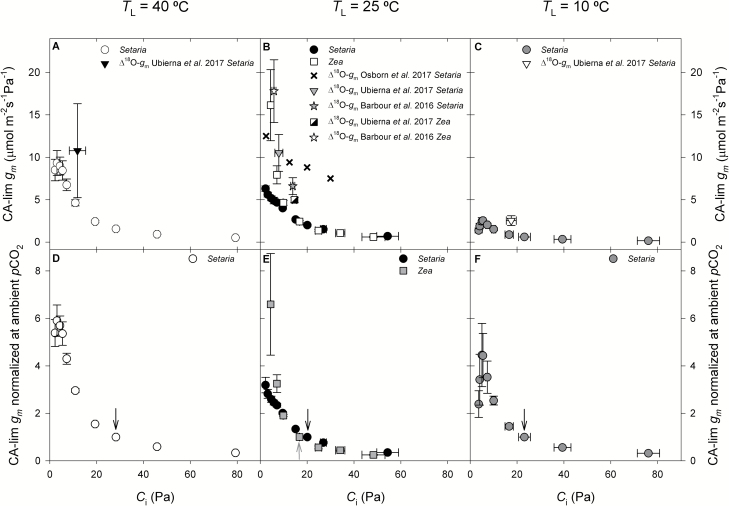
The response of carbonic anhydrase-limited mesophyll conductance (CA-lim gm) to changes in pCO2 inside the leaf (Ci) in (A, C) Setaria viridis (circles) and (B) Zea mays (white squares). Setaria was measured at three leaf temperatures, as indicated at the top of the figure. Zea was measured at TL=25 °C. For comparison, the available literature reports for Δ18O-gm for different species and temperatures are included, as indicated in the keys: Ubierna et al. (2017)Setaria measured at TL=40 °C, TL=25 °C, and TL=10 °C; Osborn et al. (2017)Setaria measured at TL=25 °C; Barbour et al. (2016)Setaria measured with block temperature of 30 °C; Ubierna et al. (2017)Zea measured at TL=25 °C; Barbour et al. (2016)Zea measured with block temperature of 30 °C. For all species and temperatures CA-lim gm significantly varied with pCO2. (D–F) The CO2 response of normalized gm, calculated by dividing individual values by the gm at ambient pCO2 at each temperature. Values are means ±SE; n=4 in Setaria, n=3 in Zea. The arrows indicate the values at ambient pCO2: black, Setaria; grey, Zea.